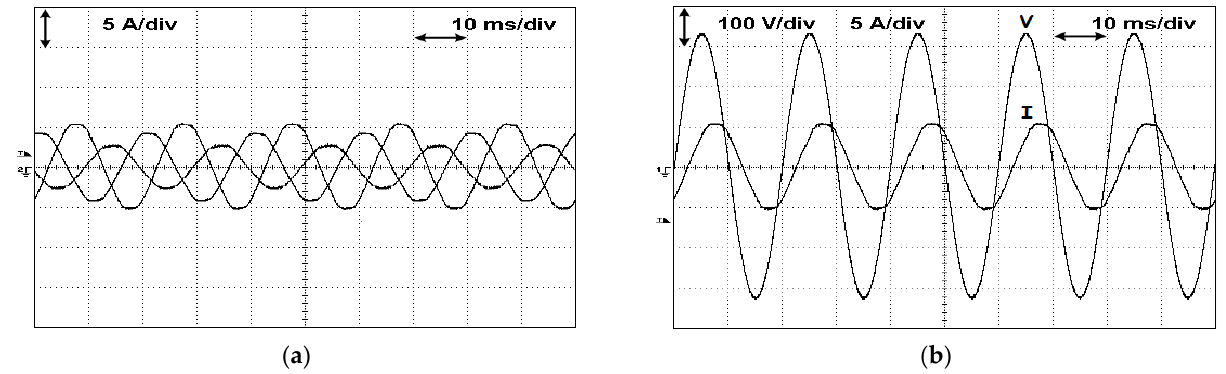
Figure 15. Waveforms obtained from the test using the PV inverter with four legs for an imbalanced condition and with reactive compensation: ( a ) three-phase currents injected by the PV system, ( b ) voltage and current in phase L 1 of the testing